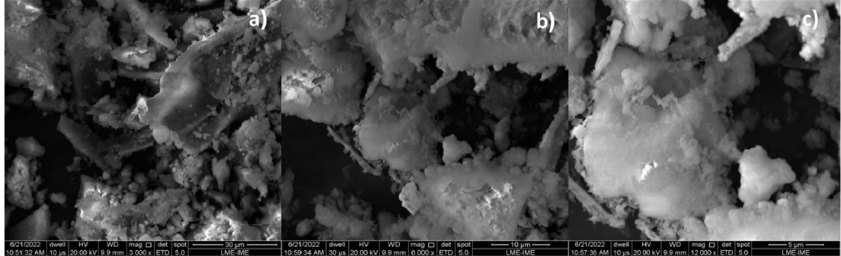
Figure 7. SEM of bio-char obtained by thermal catalytic cracking of (organic matter + paper) fraction of MHSW at 475 °C, 1.0 atmosphere, with 10.0% (wt.) Ca(OH) 2 [MAG: 3000× ( a ); MAG: 6000× ( b ); MAG: 12,000× ( c )].